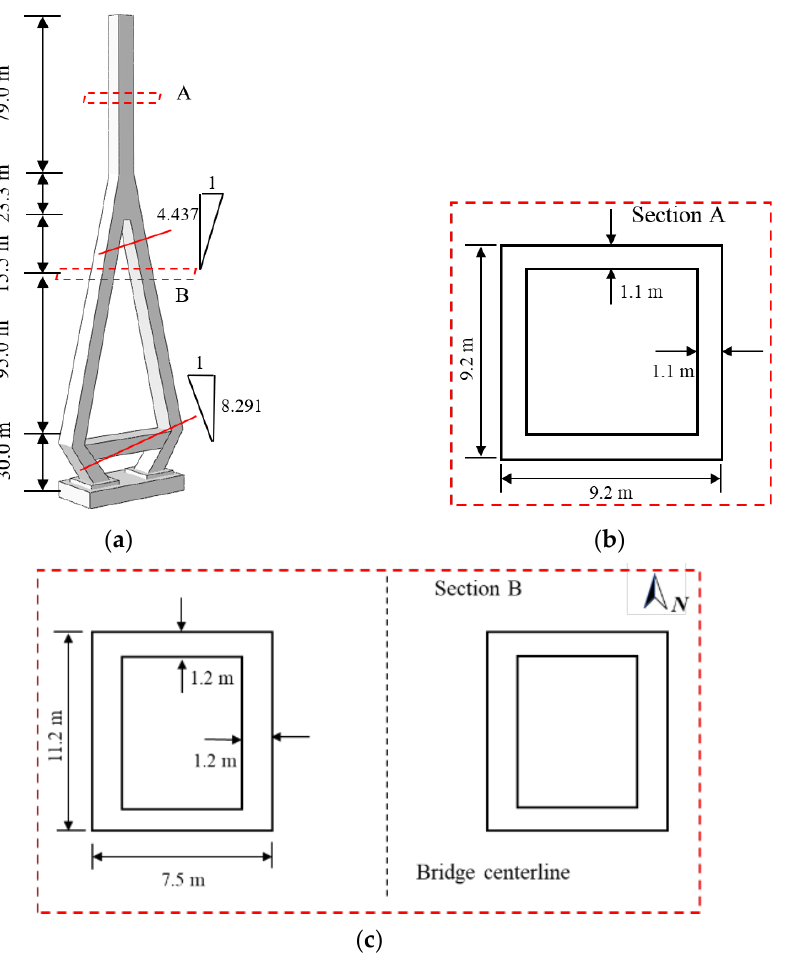
Figure 18. Schematic diagram of the bridge tower structure. ( a ) The elevation of the bridge tower; ( b ) Section A; ( c ) Section B. Table 3. Material property